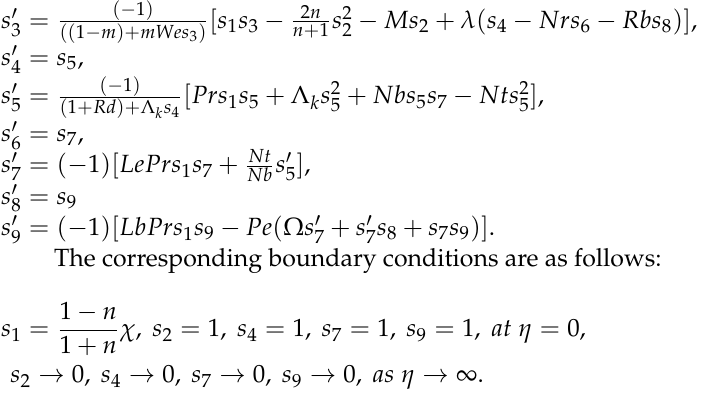
Table 3 deliberated for skin friction coefficient − f